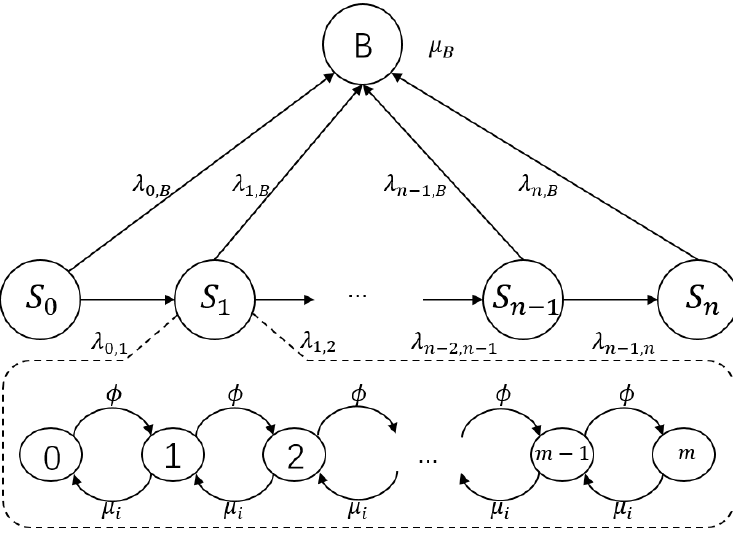
Figure 4. Multiple degradation states of cyber